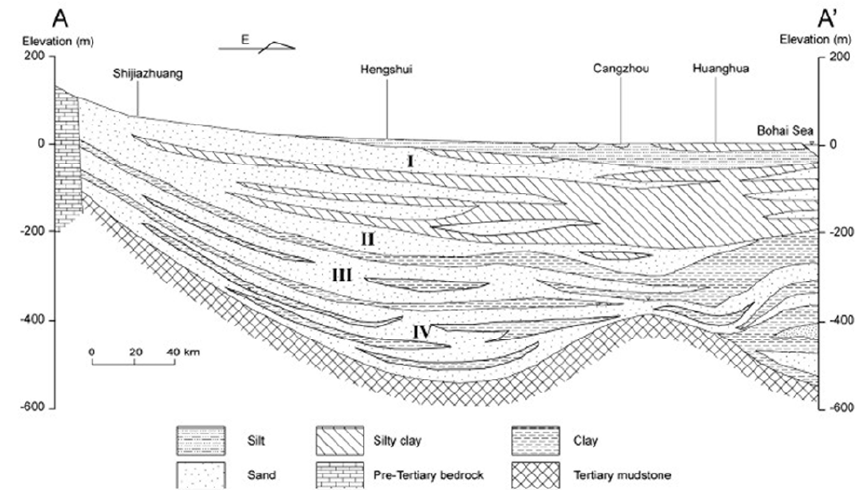
Fig. 3. Hydrogeological cross section of the NCP along A–A 0 in Fig. 1 (adopted from Chen et al., 2005, and Cao et al., 2013). Aquifer units Fig.3. Hydrogeological cross section of the NCP along A-A ′ in Fig.1(adopted from Chen et 996 I and II make up layer 1 and also shallow aquifers in the model, while aquifer units III and IV make up layer 2 and 3, respectively; aquifer III and IV are deep aquifers al. (2005) and Cao et al. (2013)). Aquifer units I and II are layer 1 and also shallow 997 aquifers in the model, while aquifer units III and IV are layer 2 and 3, respectively; and 998 aquifer III and IV are deep aquifers here. 999